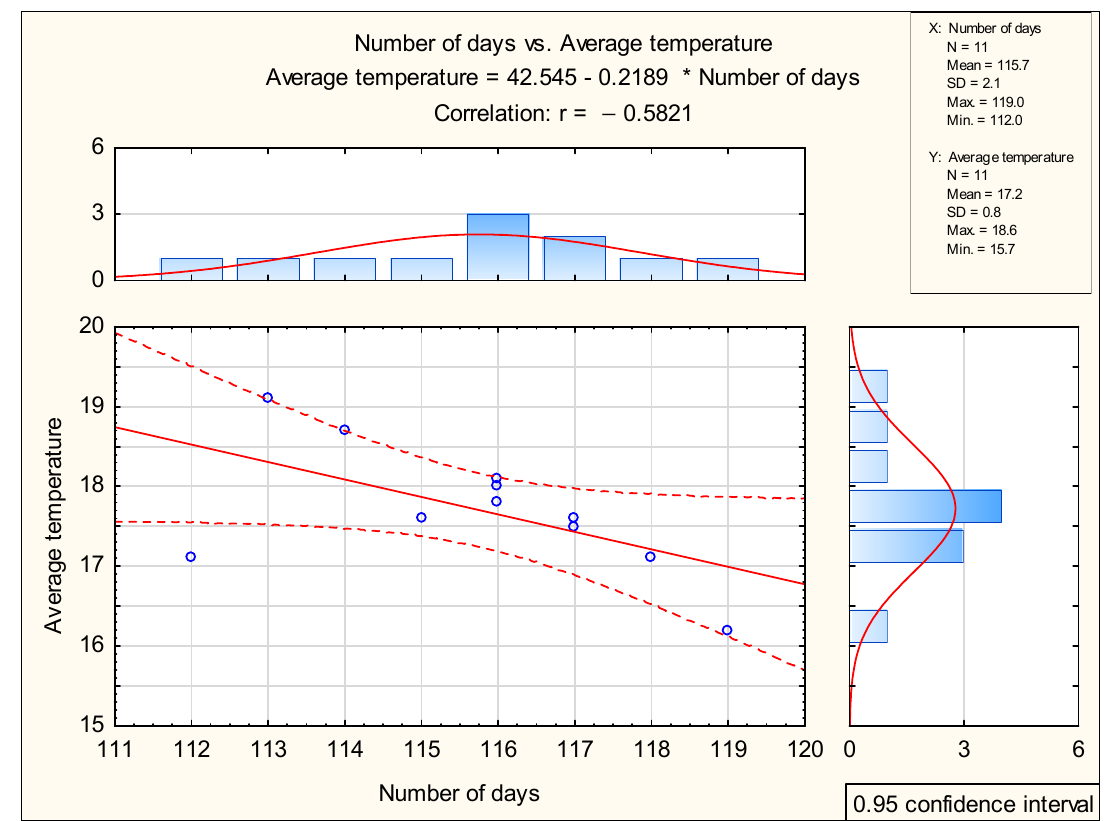
Figure 2. Scatter plot with correlation coefficient between number of days between full bloom and OHD.